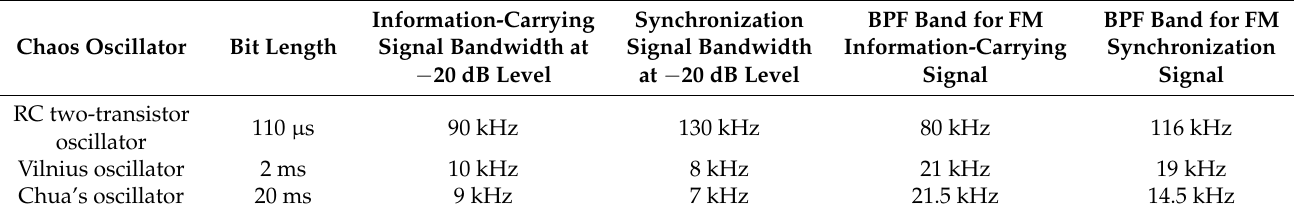
Table 4. FM-CSK system parameter selection for different chaos oscillators.